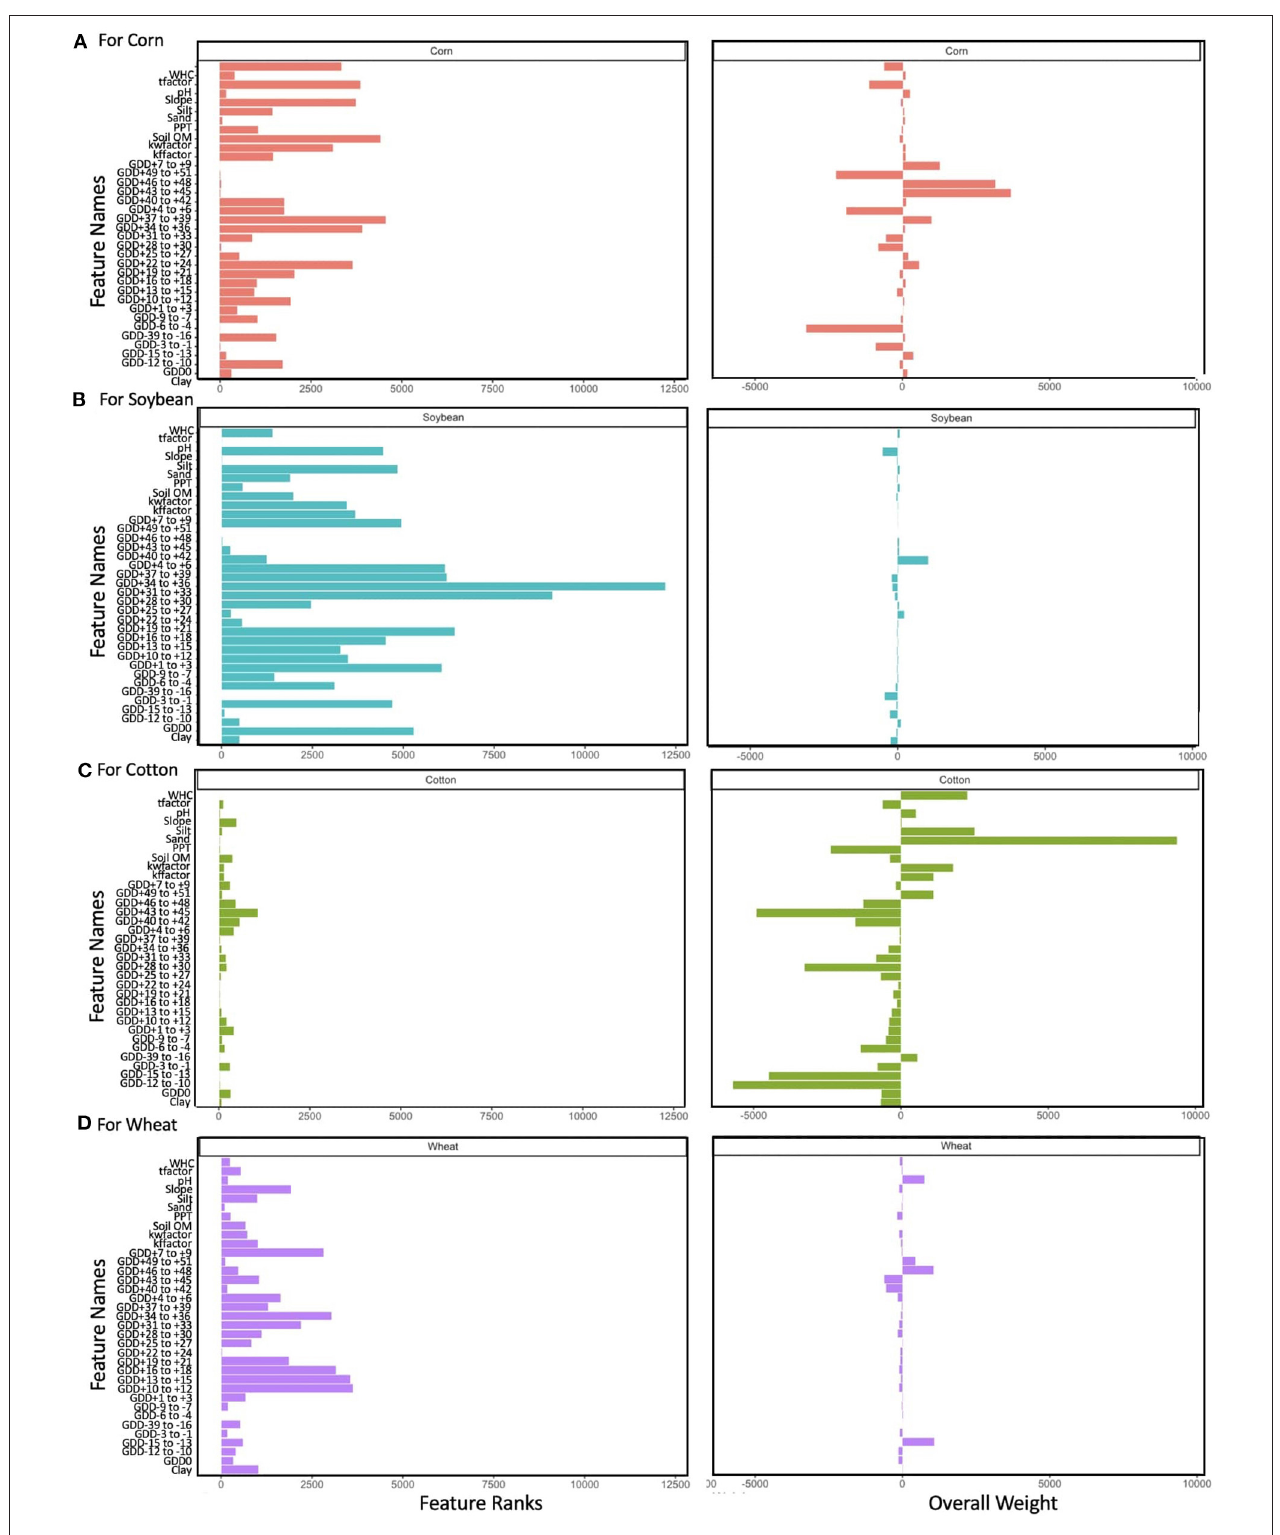
FIGURE 5 | Feature ranks and overall weight of features following explainable machine learning interpretations for (A) corn, (B) soybean, (C) cotton, and (D) wheat.